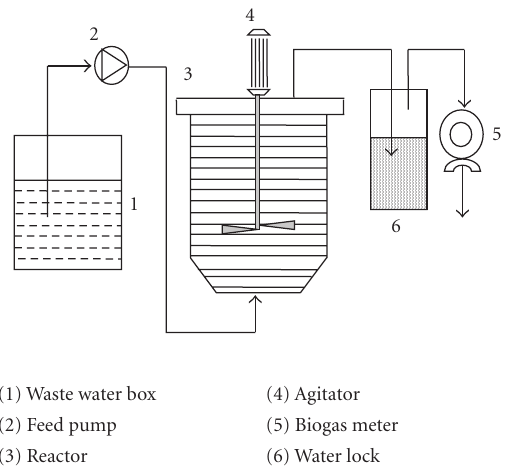
Figure 1: Schematic diagram of the CSTR reactor for biohydrogen production from molasses waste water. Table 1: Pollution of characteristics of molasses used in this study. Component